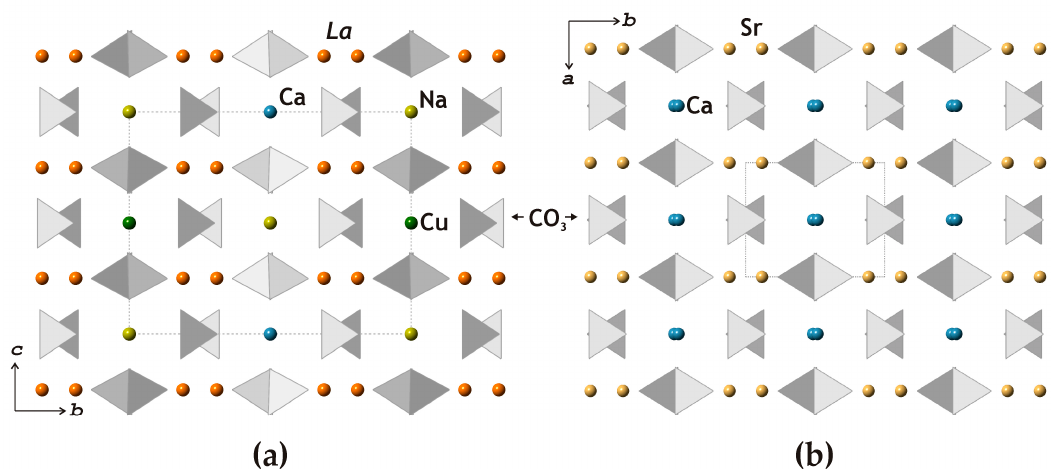
Figure 3. The crystal structures of paratooite-(La) ( a ) and carbocernaite ( b ). Legend is as in Figure 1; Sr atoms are shown as yellow spheres, and carbonate triangles are shaded in gray.